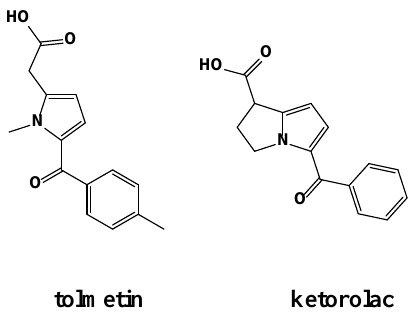
Figure 1. NSAIDs containing the pyrrole moiety.